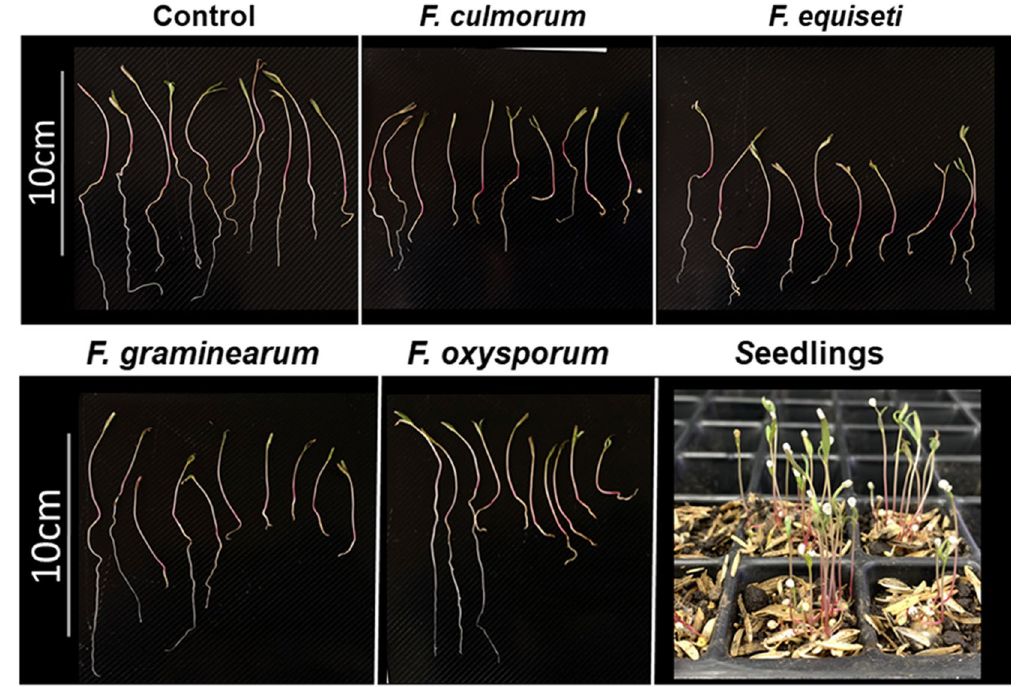
Figure 9. Affectation of root development induced by Fusarium spp. in 10-day-old quinoa seedlings. Development of seedlings of the Piartal cultivar in soils inoculated with F. culmorum , F. equiseti , F. graminearum and F. oxysporum , under greenhouse conditions. It is observed that the root development was affected by the treatments.